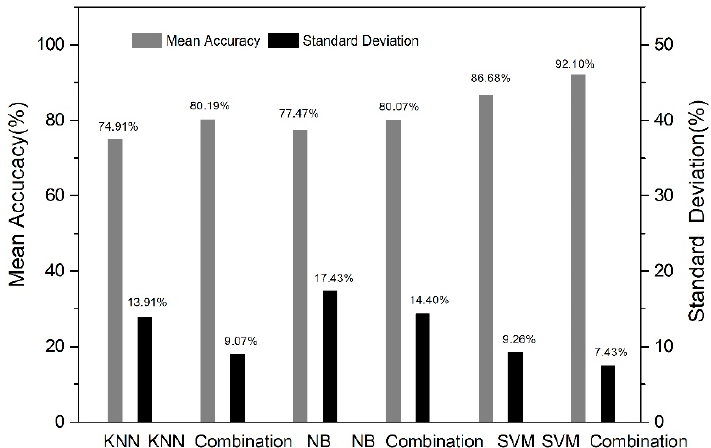
Figure 8. Performance comparison between the model combination and non-combination classifiers.